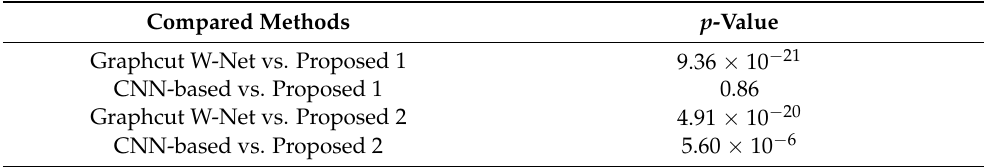
Table 2. Result of significance test between the different